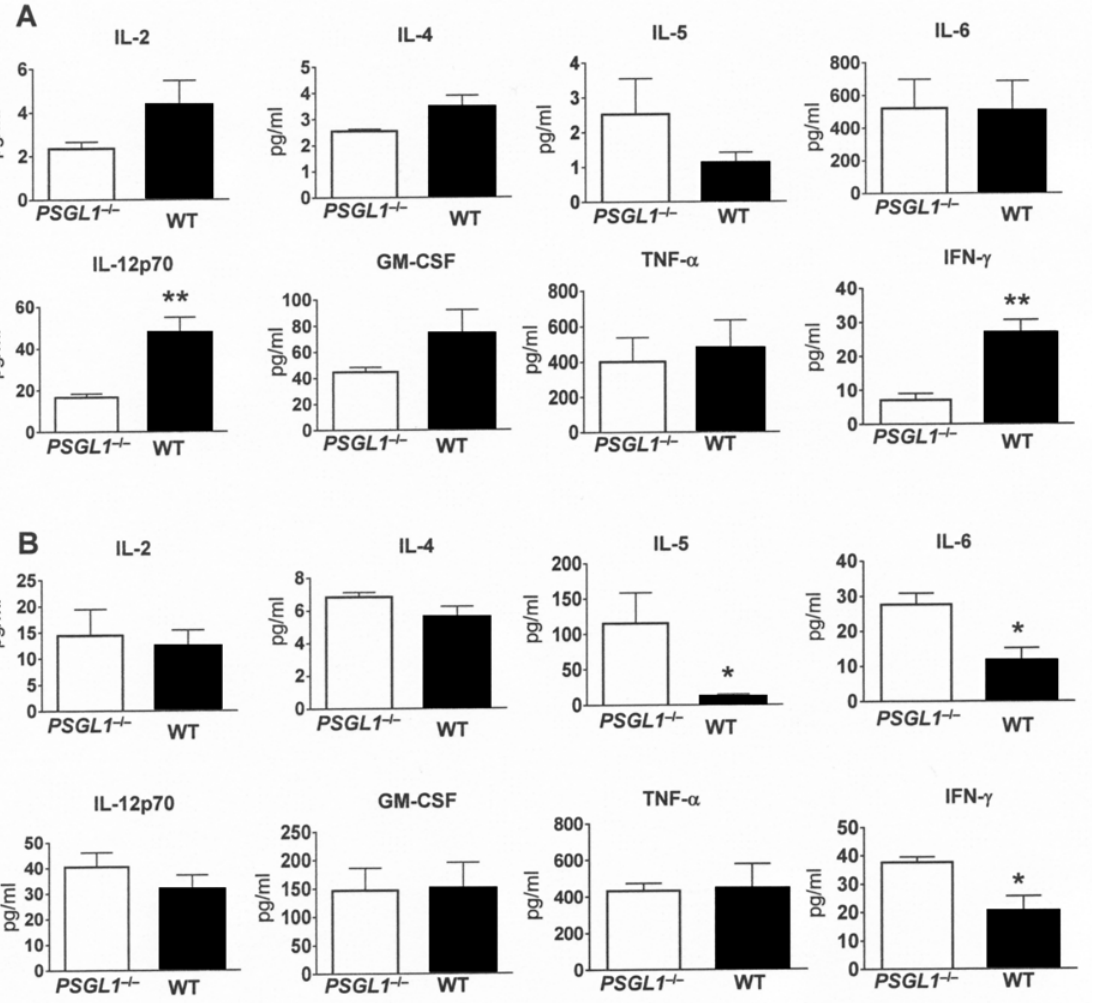
Fig 6. Impact of PSGL-1 deficiency in the inflammatory response after pneumococcal infection. Cytokine levels (pg/ml) in wild-type mice (black bars) and PSGL-1 − / − mice (open bars) at 24 h after intranasal inoculation of S . pneumoniae D39 strain. (A) Cytokines determined in BALF. (B) Cytokines measured in sera. Error bars represent the SDs and asterisks indicate statistical significance of cytokine levels of PSGL-1 − / − mice compared to wild-type